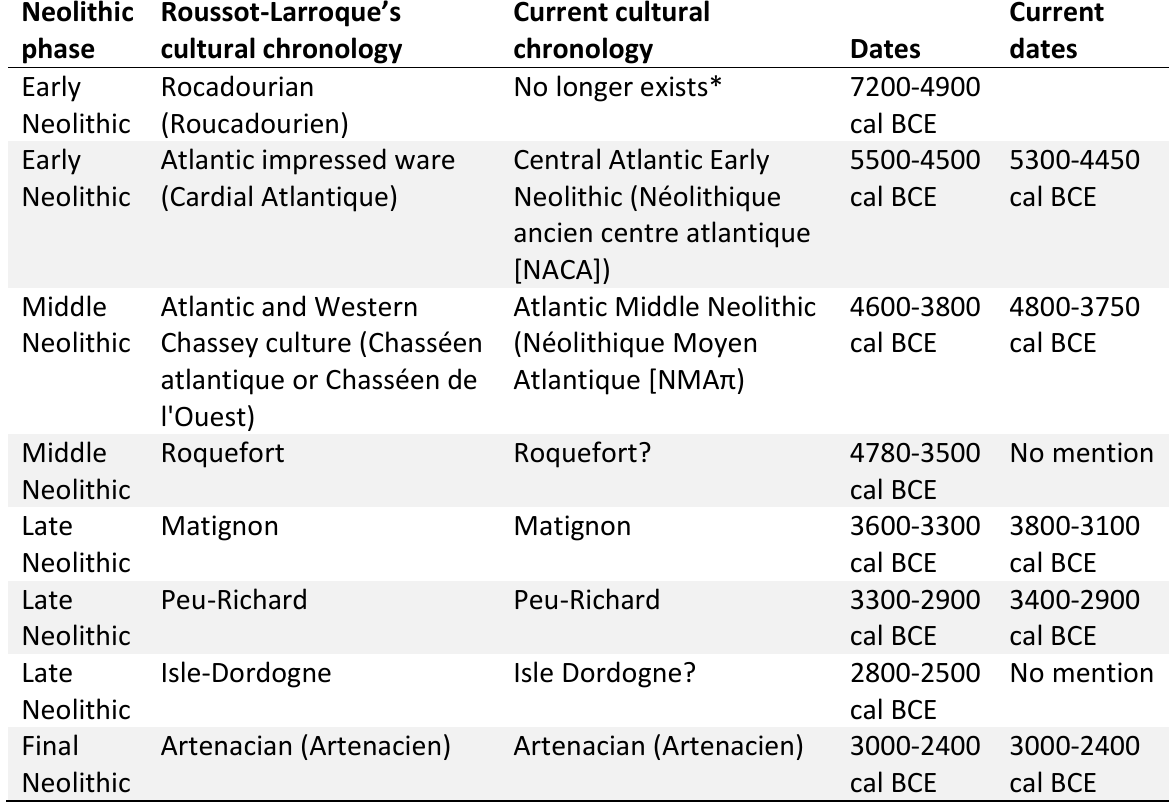
Table 1. Correspondence between Roussot-Larroque’s and recently updated chronologies of the Neolithic in the north-western Aquitaine Basin. *The Roucadourian was the result of a mixed stratigraphy between Mesolithic and Bronze Age artefacts (Valdeyron 1998). Dates (Roussot-Larroque 1998). Current dates (Dias-Meirinho & Fouéré 2008; Fouéré 1994; Marchand & Manen